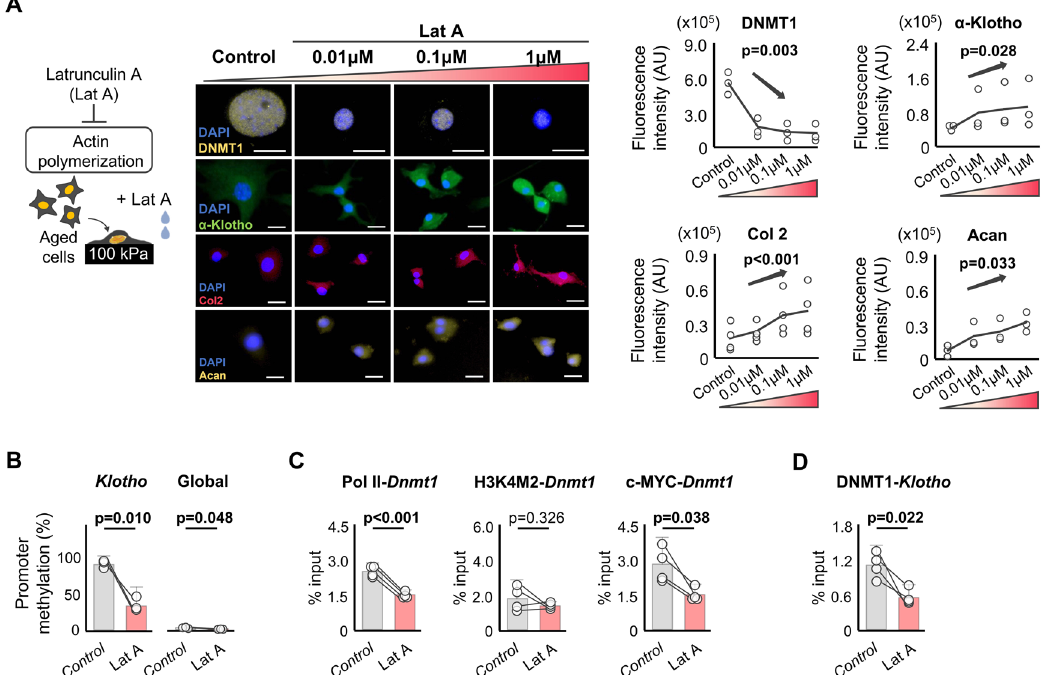
Fig. 6 | Mechanotransductive signals delivered by stiff substrates drive epigenetic repression of α -Klotho. A Latrunculin A, an inhibitor of actin poly- merization, rescued stiff matrix-induced increases in DNMT1 and reduction of α -Klotho, type II collagen (Col2), and aggrecan (Acan) in aged chondrocytes, as quanti fi ed by immuno fl uorescence ( n =3/group except for Col2 [ n =4/group]; 30 – 60 cells per individual sample). Scale bar: 20 μ m. B Inhibition of actin poly- merization blocked the stiff substrate-driven increased Klotho promoter and glo- bal DNA methylation in aged chondrocytes ( n =3/group). C Inhibition of actin polymerization blocked the stiff substrate-driven increased binding of RNA